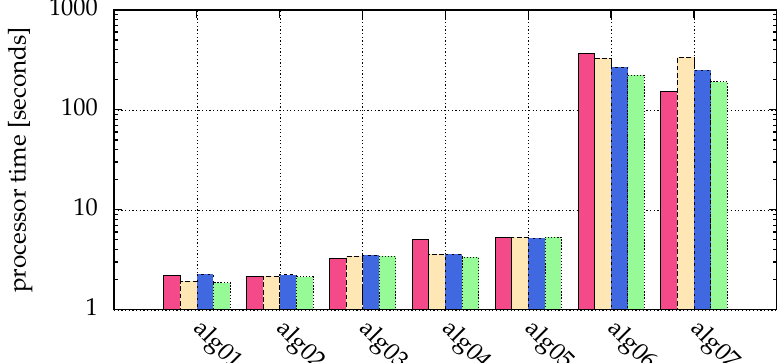
Figure 12. Comparison of used processor time of the simulations of Figure 5: pink ( (cid:4) ) bars for SNR = 5, yellow ( (cid:4) ) for SNR = 10, blue ( (cid:4) ) for SNR = 100 and green ( (cid:4) ) for SNR = 1000. The ordinate shows the measured processor time in seconds on an Intel Xeon processor E5-2643v3. The statistics/simulation was done with images containing 10,000 particles with σ { x , y } =